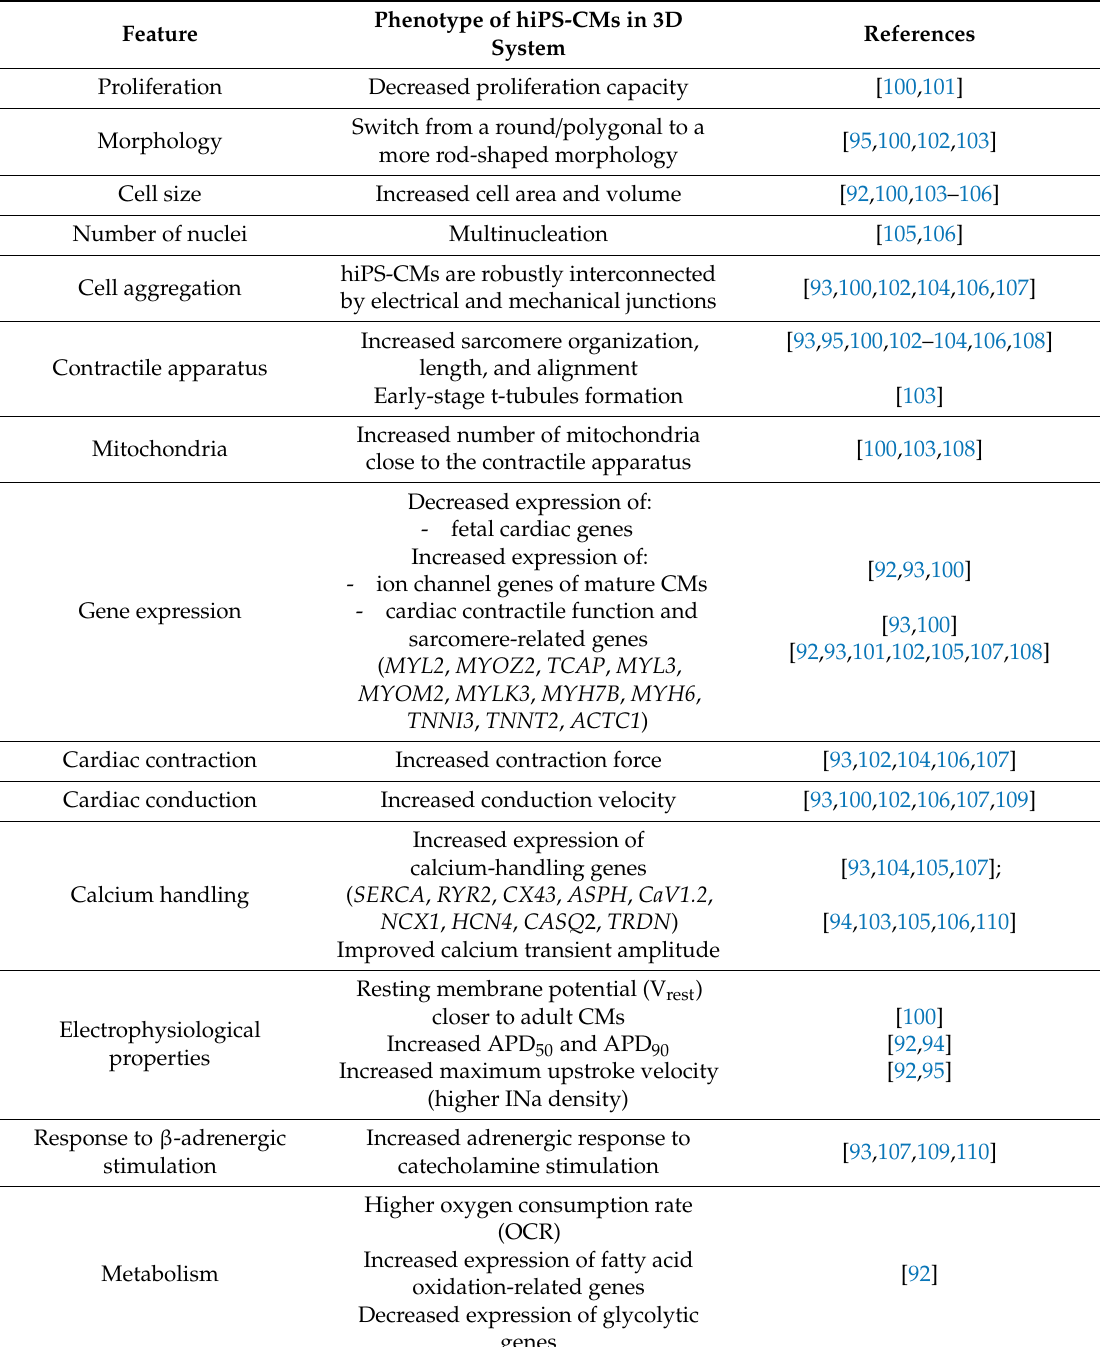
Table 2. Improved maturation of hiPS-derived cardiomyocytes within 3D